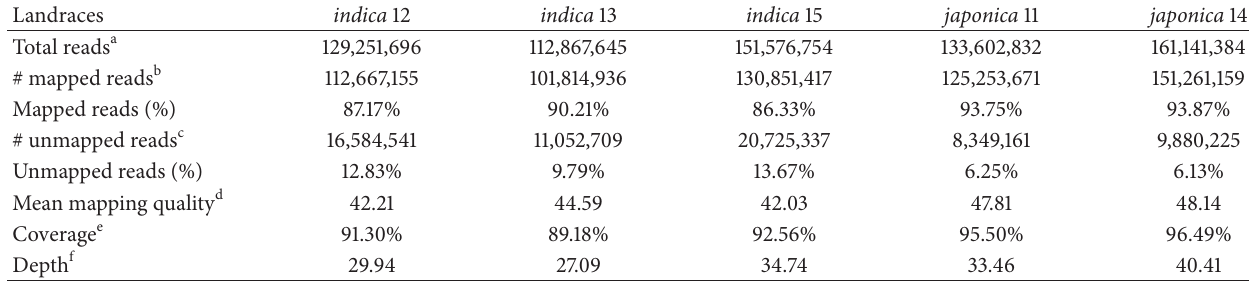
Table 2: Mapping and coverage of the reads from the landraces to Nipponbare reference genome.